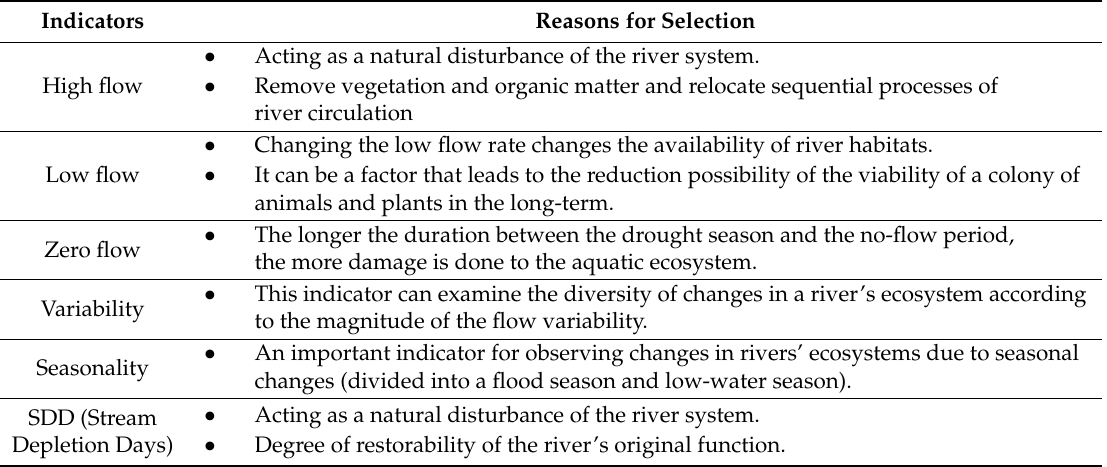
Table 2. The hydrologic evaluation